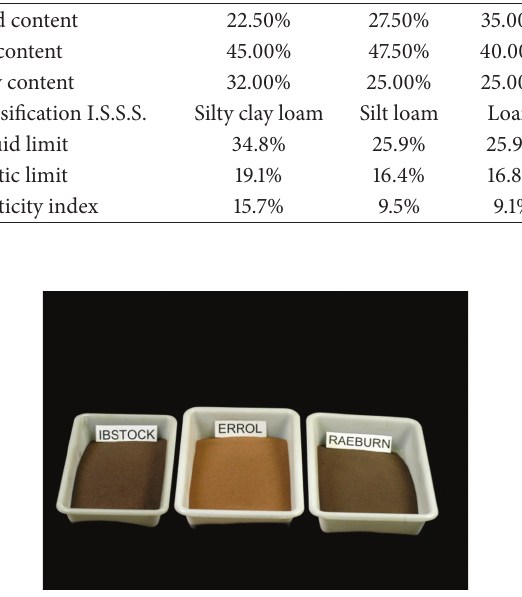
Figure 1: Photograph of the three soil types